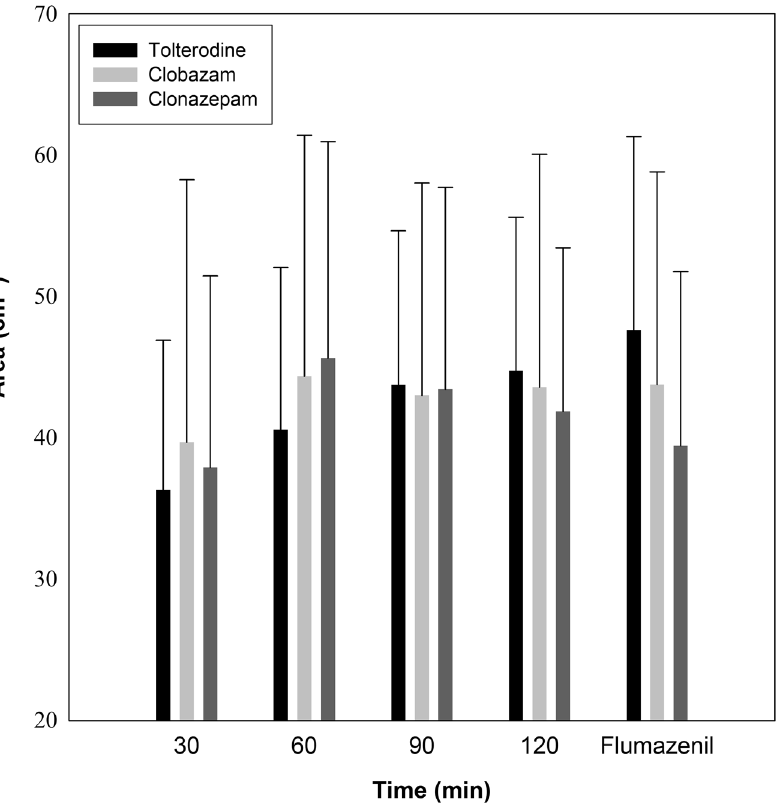
Figure 4. Static pinprick hyperalgesia after capsaicin. The area of static hyperalgesia significantly increased with the active placebo tolterodine (p , 0.001), but not with clobazam and clonazepam.